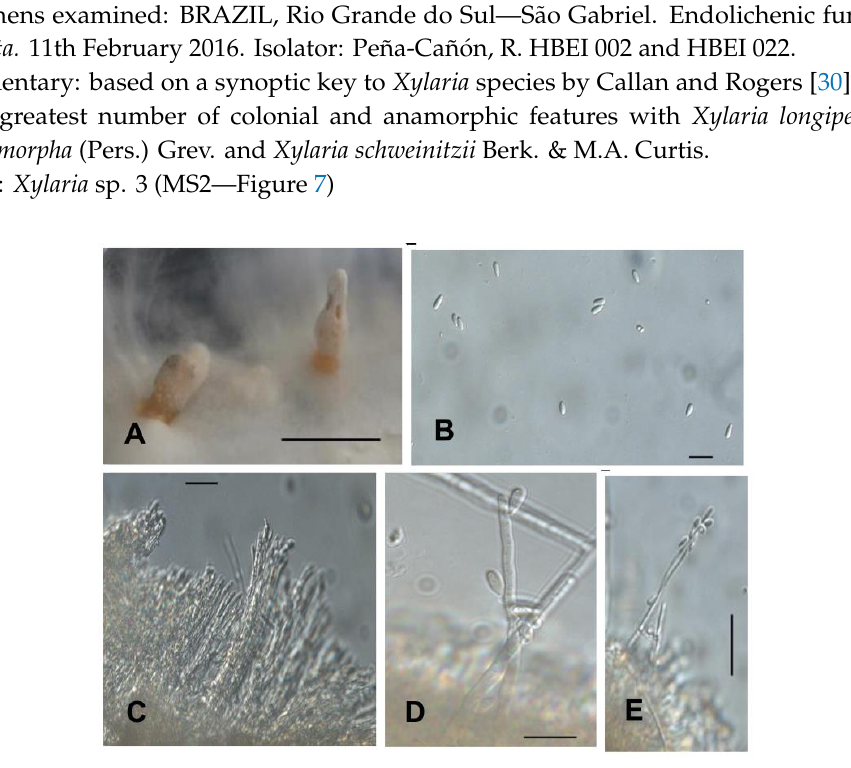
( C ) Figure 8. Re-synthesis evaluation in vitro: ( A ). Xylaria spp. mycelia growing without photobionte. ( B ). Contact of mycelium with Trebouxiaceae biomass. ( C ). Close-up showing an interaction with fungi mycelia and algae cultures.